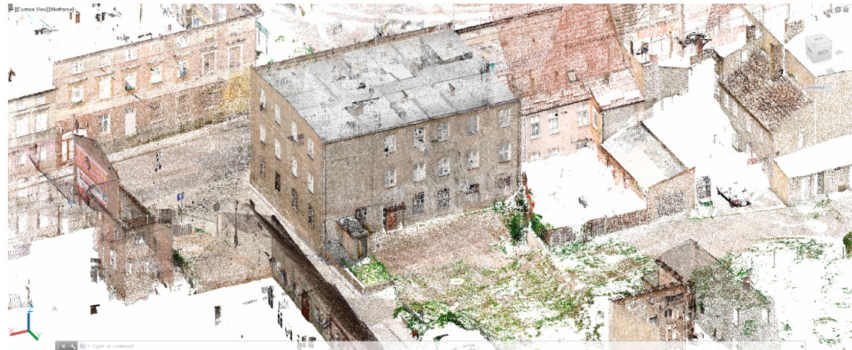
Figure 8. Outside view of the building made using TLS in Autocad 2015—axonometry.